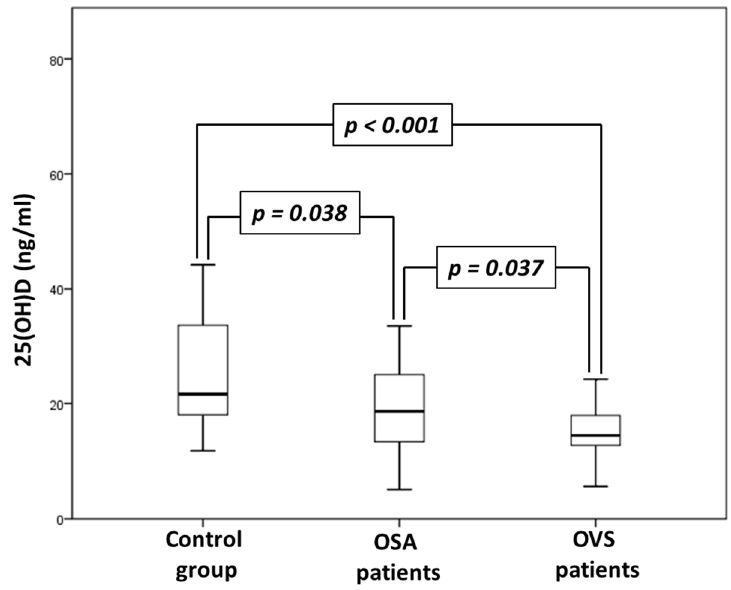
Figure 1. Comparison of 25(OH)D serum levels between control, obstructive sleep apnea syndrome (OSA) and overlap syndrome (OVS) groups. Table 3. Comparison of measurements and laboratory analyses between control, obstructive sleep apnea syndrome (OSA) and overlap syndrome (OVS) groups. Control Group ( n =